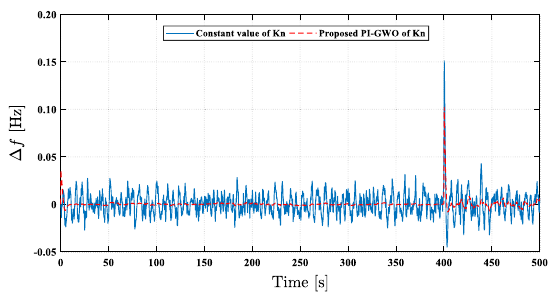
Fig. 7 The frequency deviation of Case